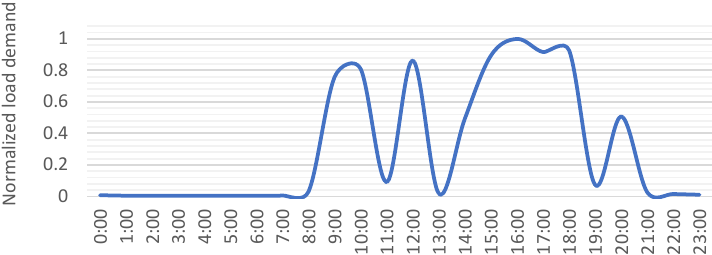
Figure 1. Standardized characteristic load profile of an industrial customer, according to company records (own elaboration).